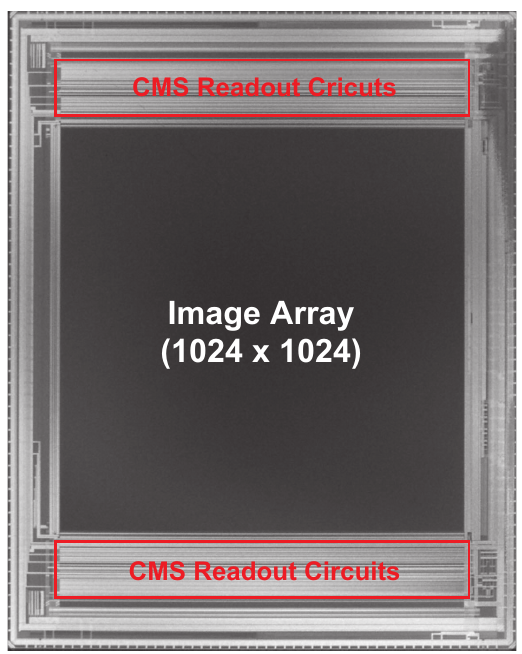
Figure 9. Implemeted chip photomicrograph.